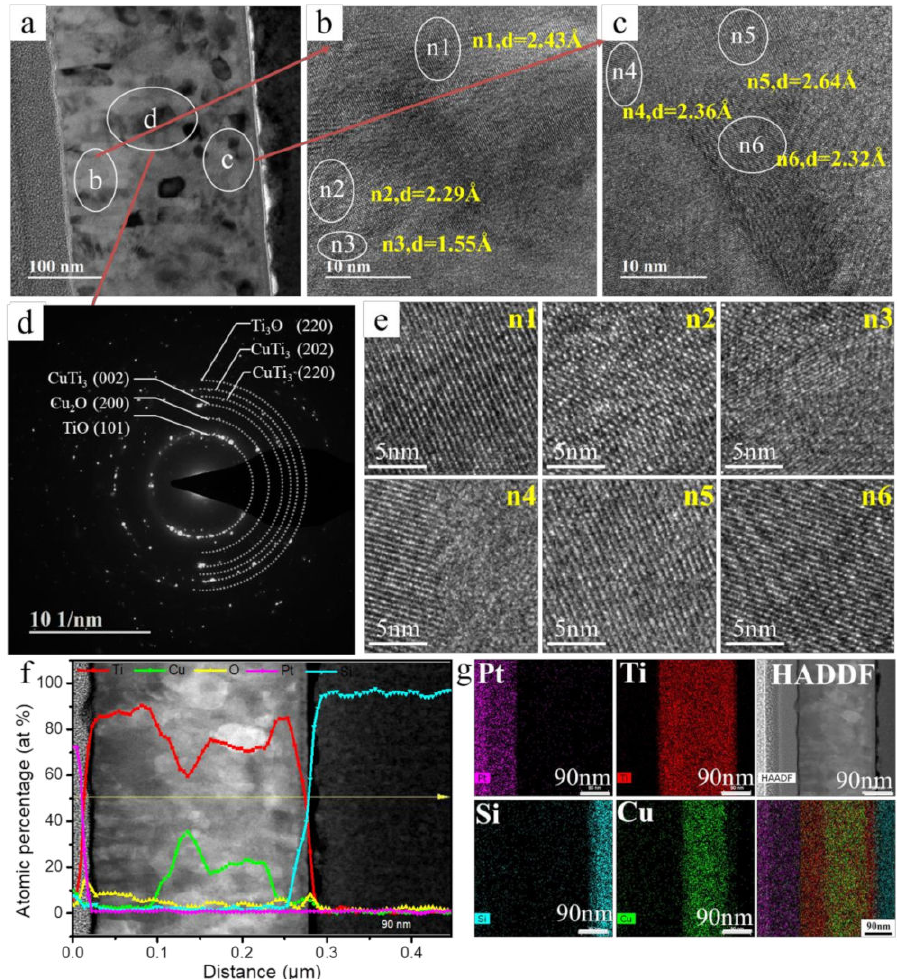
Figure 4. Cross-sectional transmission electron microscopy (TEM) results obtained for the Ti–Cu coatings annealed at the temperature of 500 ◦ C on silicon substrates: ( a ) low magnification field image; ( b , c ) corresponding HRTEM images; ( d ) corresponding selective area electron di ff raction (SAED) image; ( e ) corresponding HRTEM images; ( f ) EDS line scans showing the distributions of the elements (Pt, Ti, Si, Cu, O) in the high-angle annular dark-field (HADDF) image; ( g ) corresponding EDS mappings of the distribution of elements (Pt, Ti, Si, Cu) in the HADDF